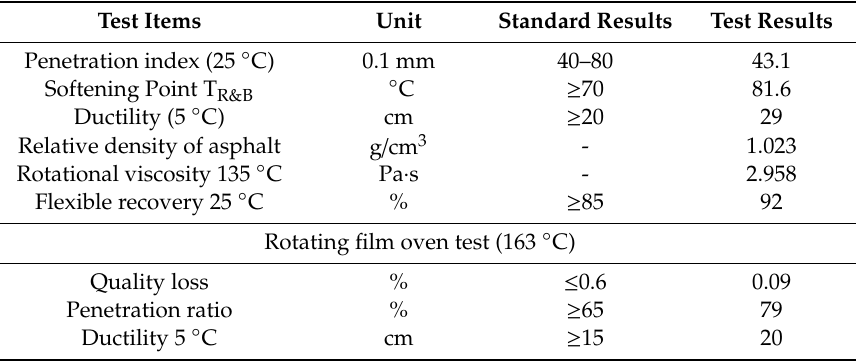
Table 2. Properties of asphalt binder.